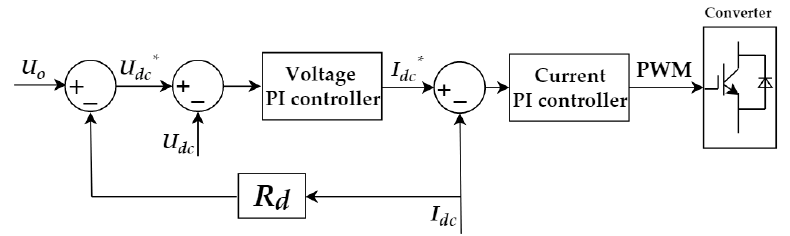
Figure 2. The block diagram of the DC droop control. PWM: Pulse width modulation.